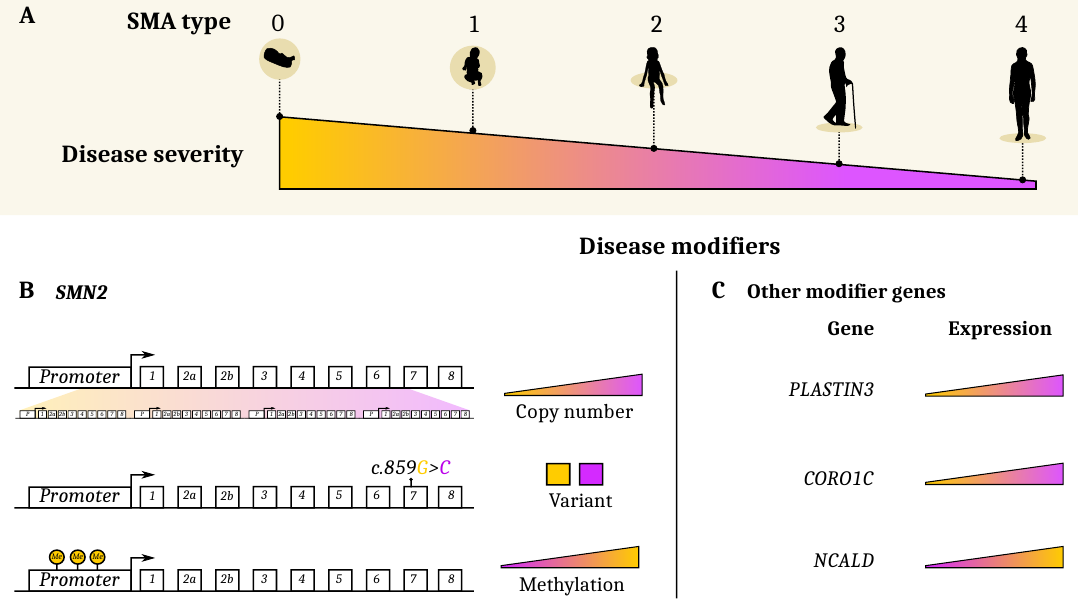
Figure 1. Known molecular disease modifiers. ( A ) Current classification of SMA as a discrete projection of a continuous spectrum of disease severity. This spectrum results from the combination of ( B ) disease modifiers such as SMN2 copy number, SMN2 variant, and methylation state; ( C ) level of expression of CORO1C and PLASTIN3 was associated with milder phenotype, while NCALD overexpression was associated with more severe